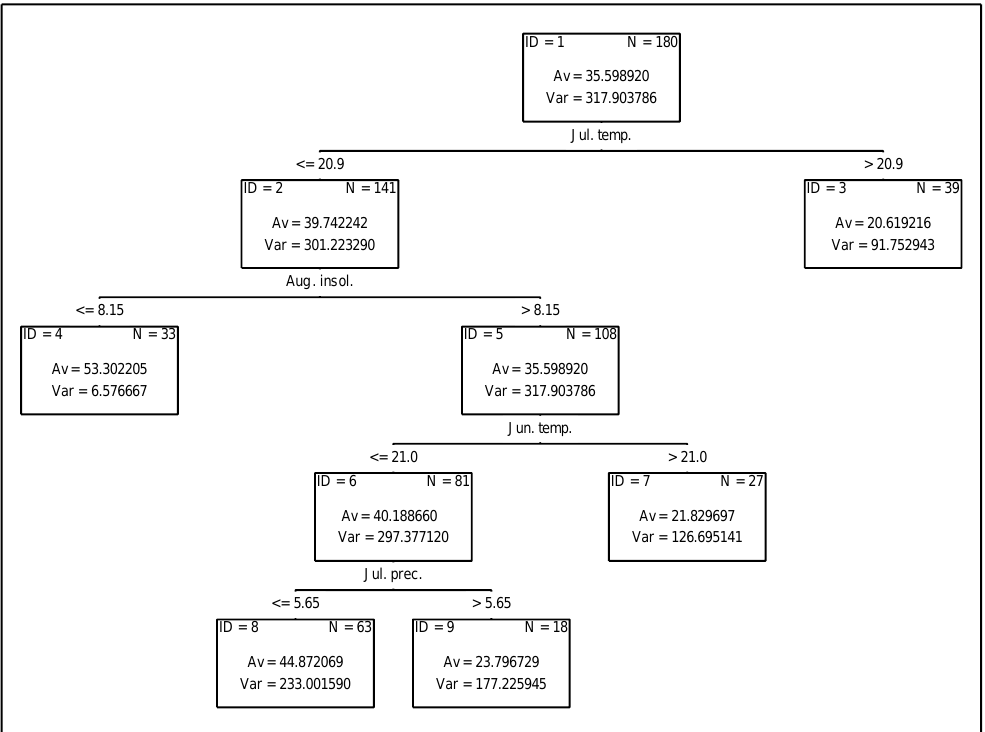
Figure 4. Diagram of regression tree reflecting nitrogen acquisiton from the atmosphere by control soybean plants.